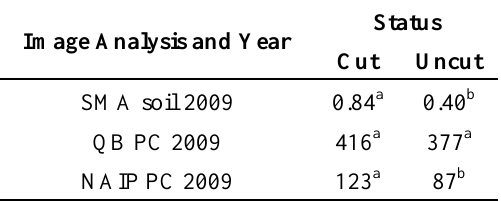
Table 6. School Fire SMA and PCA regression model results and tests of significance. The model form was: soil exposed or PC1 disturbance = cut * harvest intensity. Same letters in a row (a,b) indicate no significant difference at α =